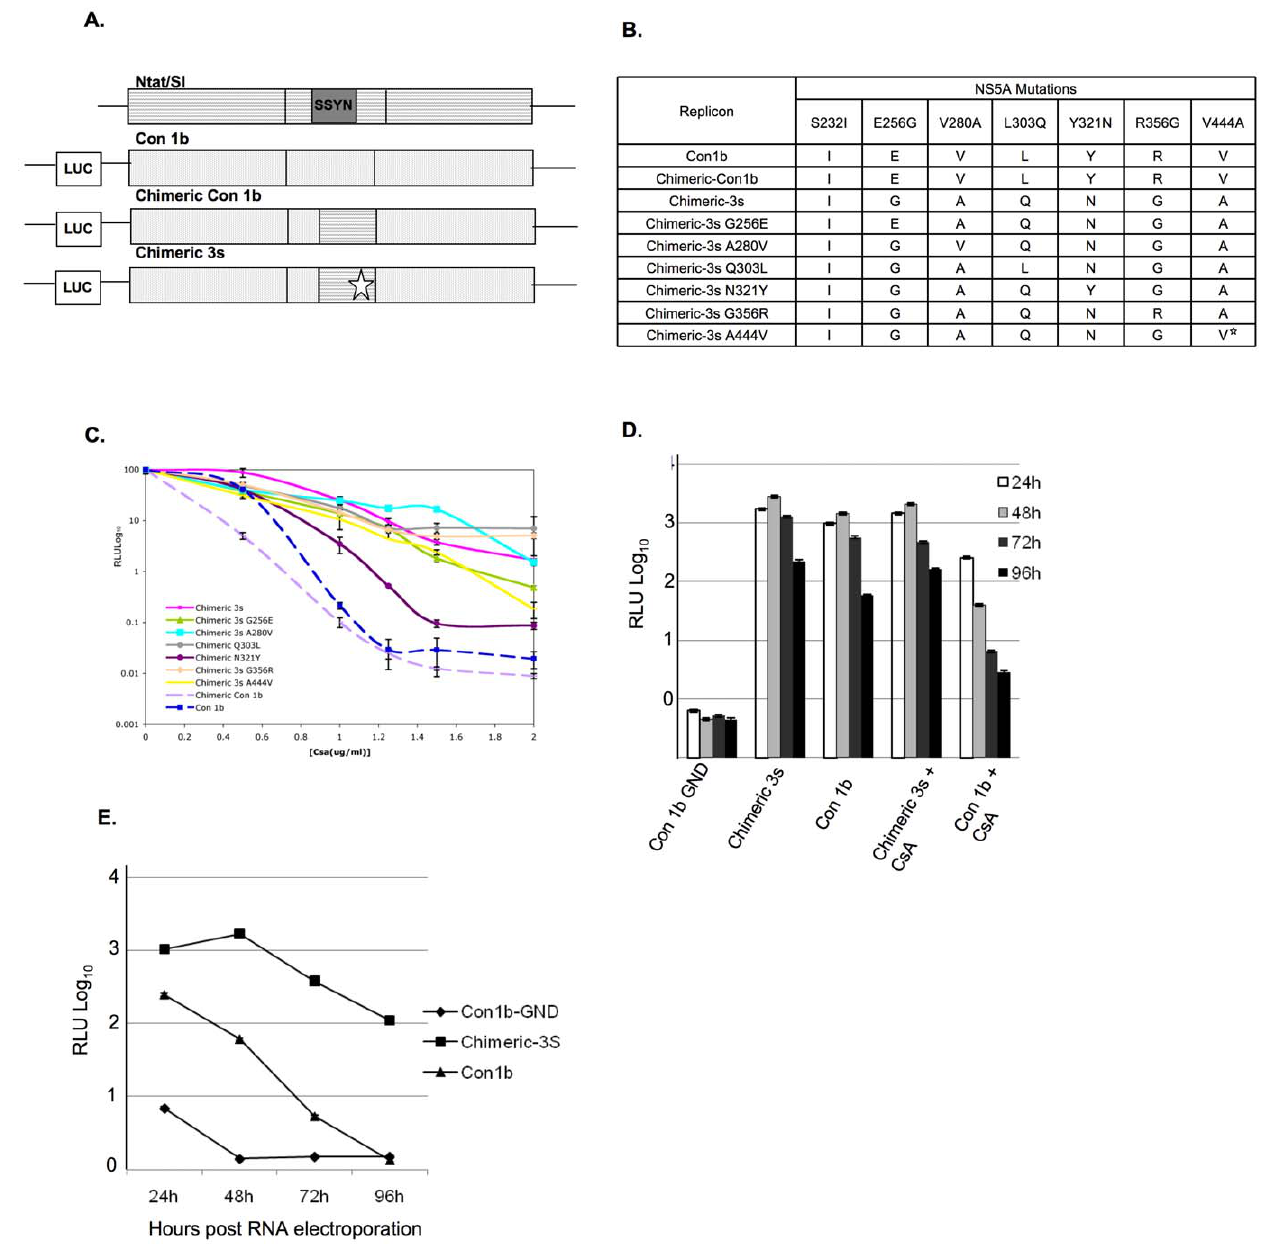
Figure 2. CsA sensitivity of different chimeric 3s replicons. (A) Schematic representation of different Chimeric replicons derived from Con1b and Ntat/SI. Star represents all 3s mutants (acc. no. EF115302), SSYN insert present only in 1bN replicon. = Con1b sequence, = 1bN sequence. (B) List of cyclosporineresistantmutations clonedin a con 1b background. Star indicatesreversionof that particular amino acid. (C)Equalnumbers of replicon cells were seeded for the Con 1b, Chimeric Con1b, and Chimeric 3s variants. The cells were treated with different concentrations of CsA as indicated on the x axis and assayed for luciferase activity. The y axis shows relative light units Log values (RLULog 10 ). Error bars represent standard deviations from three separate experiments read in triplicate. Student’s t test was used to calculate p values. Con 1b vs Chimeric 3s N321Y P , 0.0001 at 1, 1.5, and 2.0 m g/ml CsA. Chimeric 3s N321Y vs Chimeric 3s P , 0.0001 at 1, 1.5, and 2.0 m g/ml CsA. (D) Huh7.5 cells were electroporated with Chimeric Con1b and Chimeric 3s replicon RNA and plated in either the presence or absence of 1.0 m g/ml CsA. Equal numbers of cells were harvested at 24, 48, 72, and 96 hours and analyzed for luciferase activity (RLULog 10 ). Three independent RNA electroporations were performed and average luciferase readings are presented for the indicated time points. Error bars represent standard deviation (E) Huh7.5 cells were electroporated as in (D) except the cells were pretreated with 1.0 m g/ml CsA for 6 days and plated in the presence of drug. Equal numbers of cells were collected and luciferase activity was analyzed (RLULog 10 ). The average of three independent RNA electroporations is presented. Error bars represent standard deviation.